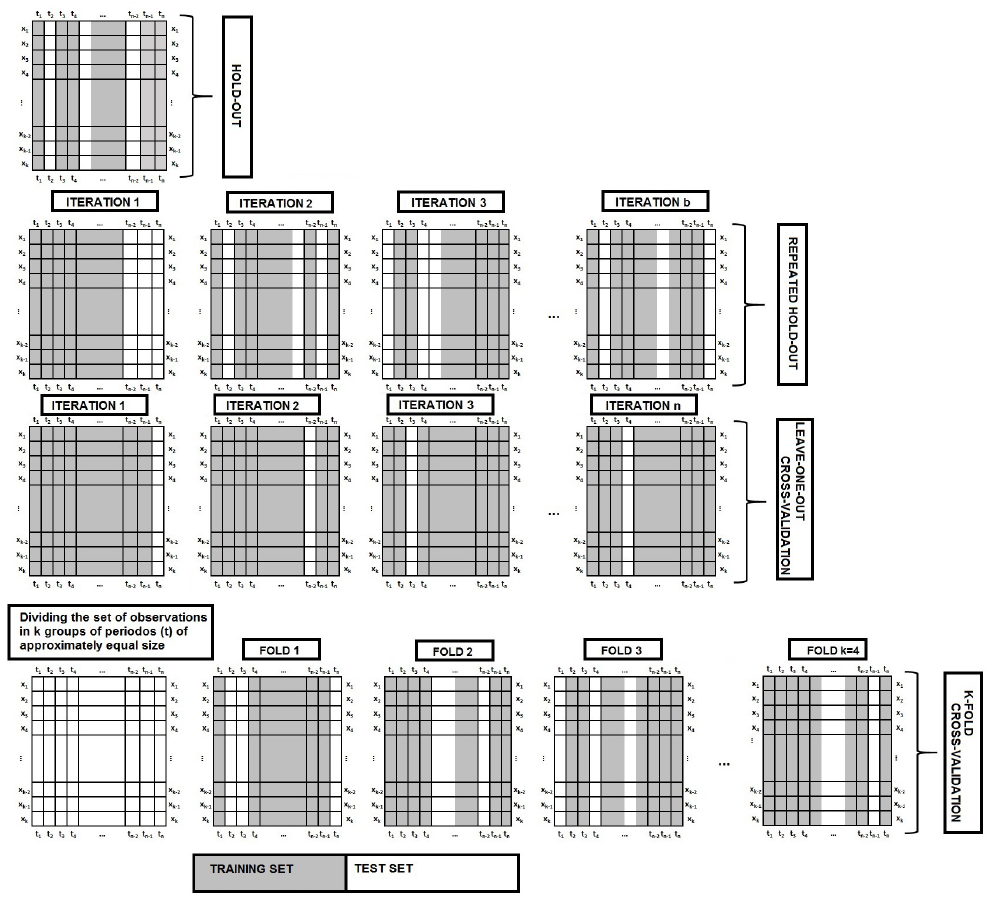
Figure 2. A schematic display of the employed resampling methods for nonembedded time series. The training sets and validation sets are shown in gray and white,